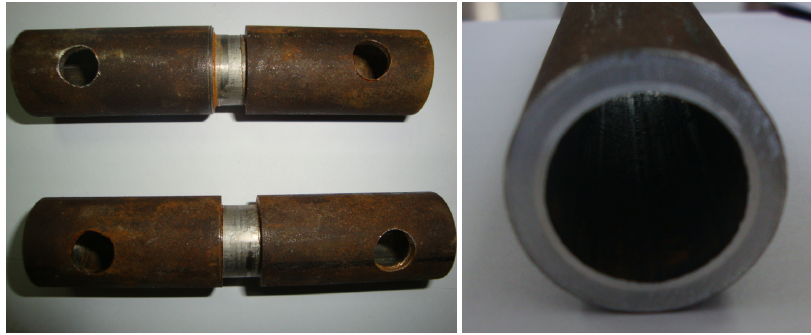
Figure 7: The entity graph of bimetallic clad tube specimen